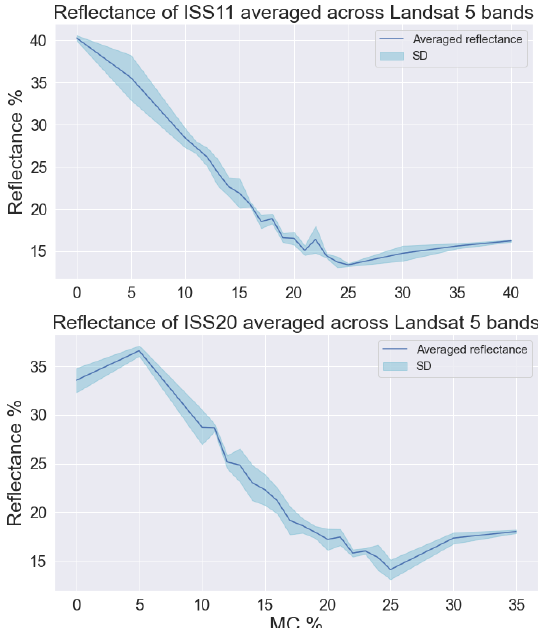
Figure 9(a & b). The reflectance of single samples e.g. ISS11(a) and ISS20(b) averaged across the Landsat 5 bands, decrease in a monotonic, linear fashion, as MC increases.